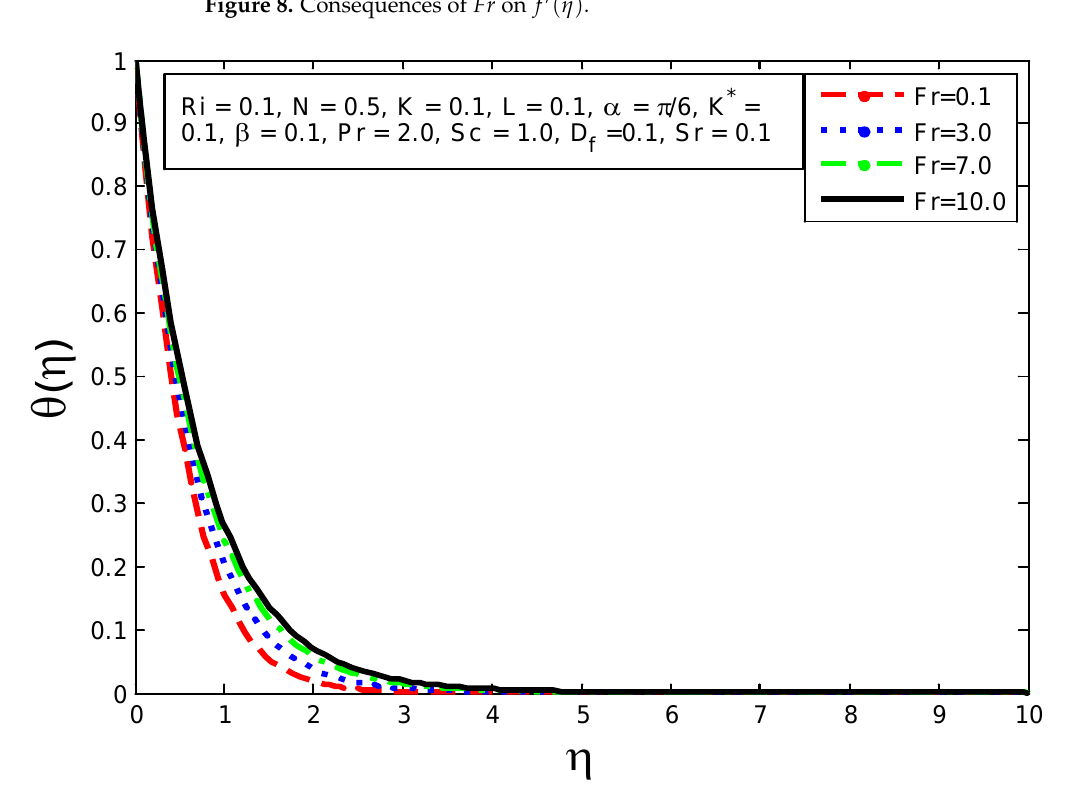
Figure 9. Consequences of Fr on θ ( η )